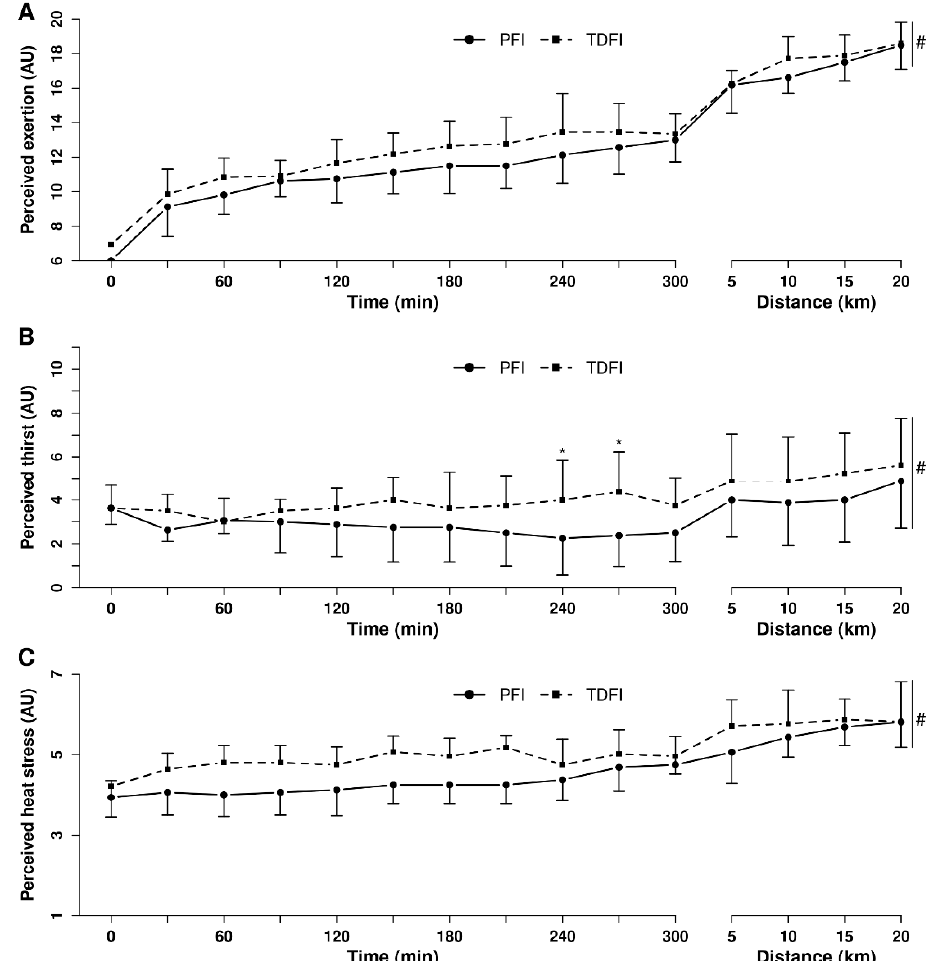
Figure 5. Perceived exertion ( A ), thirst ( B ) and heat stress ( C ) during the 5 h fixed-workload exercise period and the 20 km time-trial for the programmed (PFI) and thirst-driven fluid intake (TDFI) strategies. * p < 0.05 for difference between conditions, # significant time effect ( p < 0.001). Vertical dotted line represents the onset of the time-trial. AU = arbitrary units. Values are means ± SD.